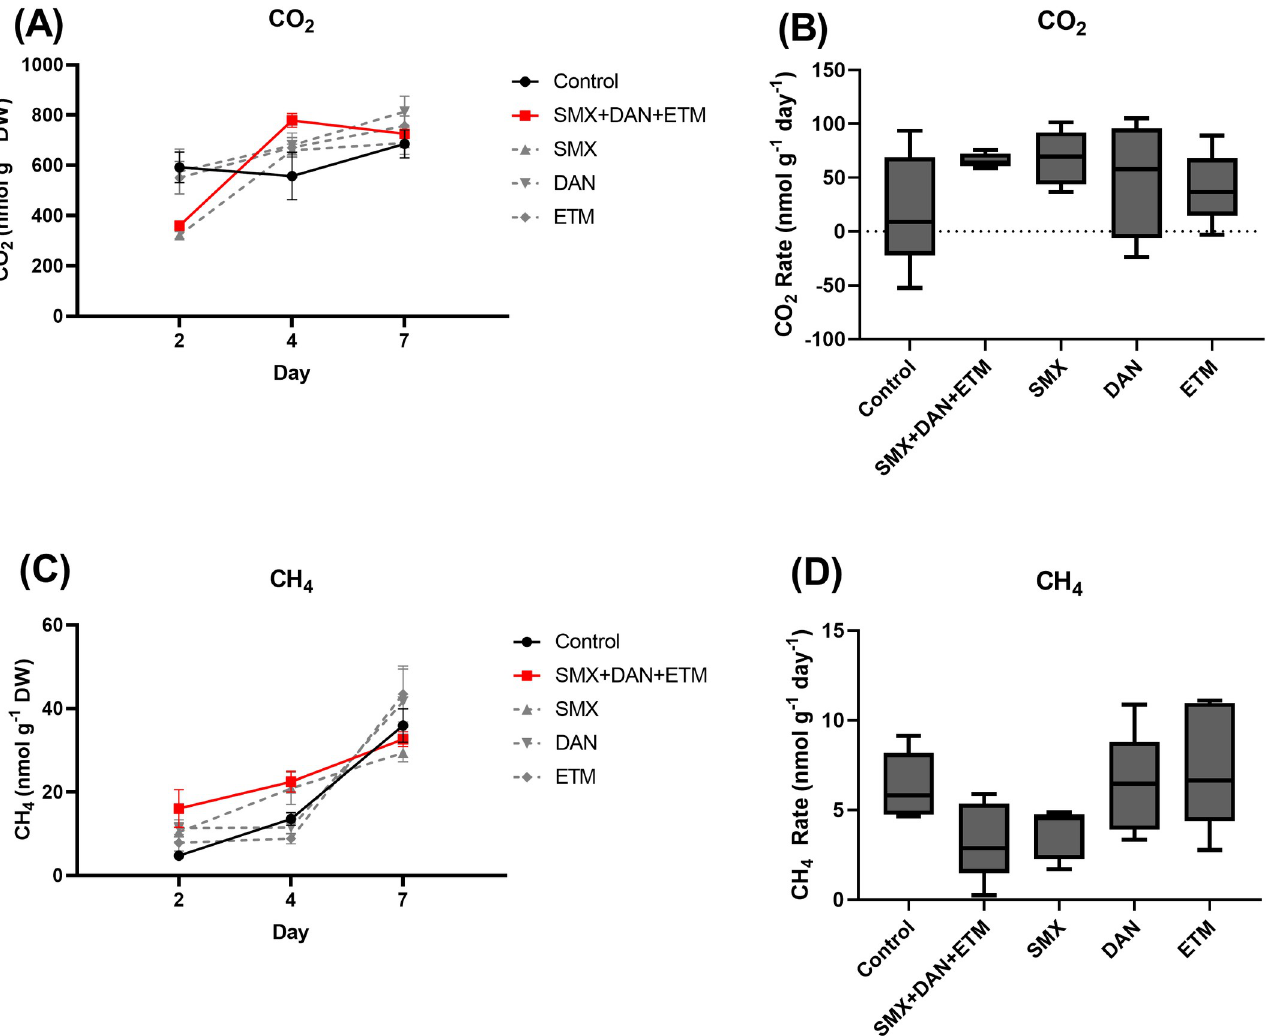
Fig 3. Mean ± SE dissolved (A) CH 4 , (C) CO 2 concentrations in microcosms plotted across time (Day 2, 4, and 7) and whisker plots (min to maximum) of the rate of production for (B) CH 4 and (D) CO 2 from microcosms exposed to control and experimental